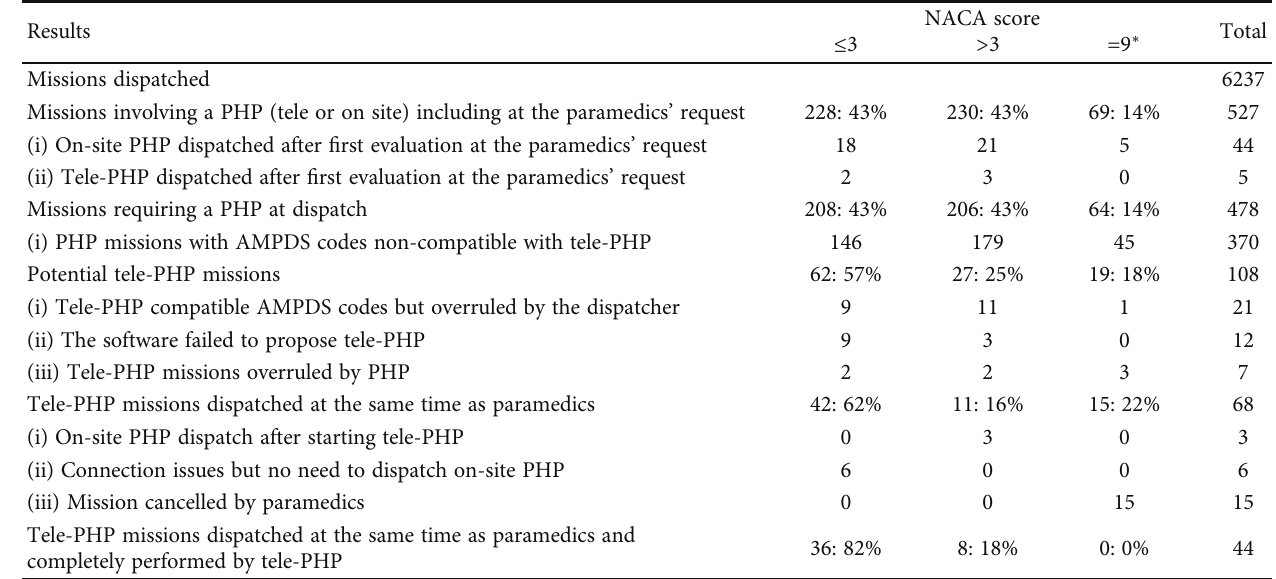
Table 4: National Advisory Committee for Aeronautics (NACA) score of all missions involving a prehospital emergency physician (PHP) or a telemedicine with a prehospital emergency physician